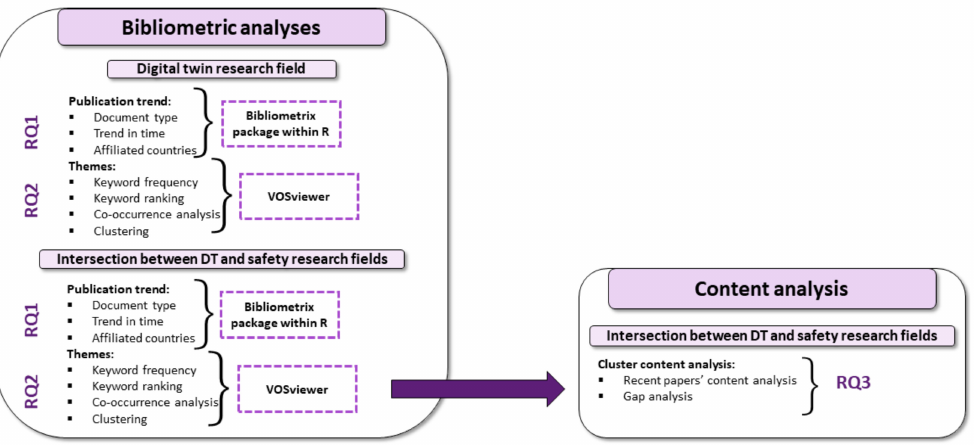
Figure 3. Methodological